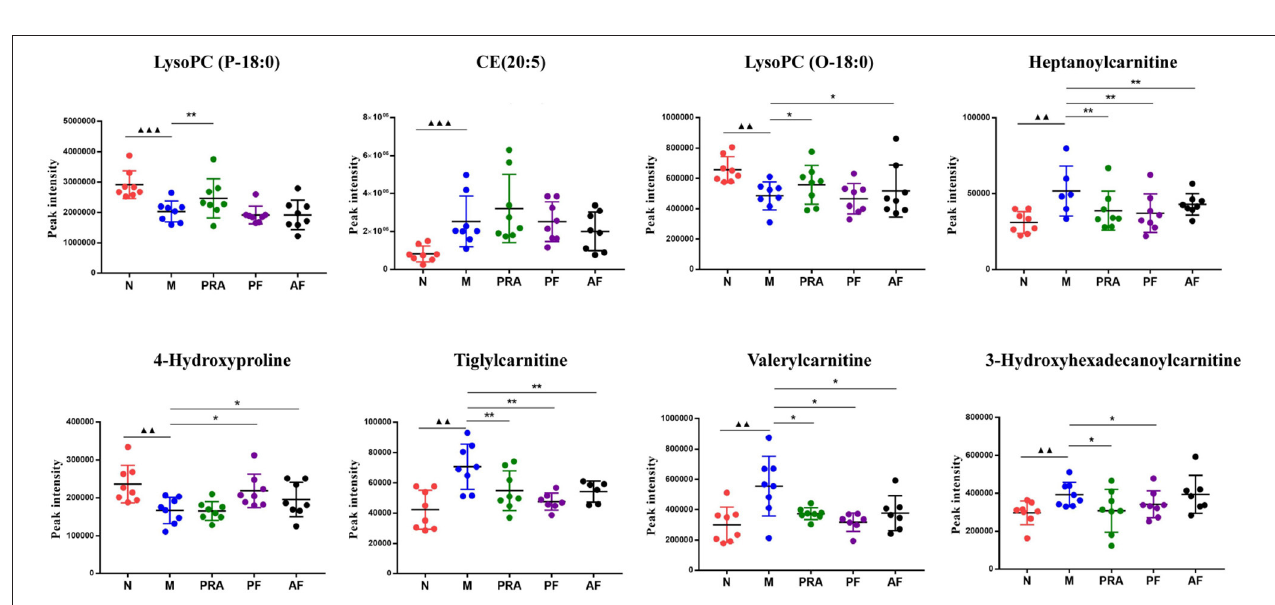
FIGURE 7 | ROC analysis of potential biomarkers in the serum and cerebral cortex.